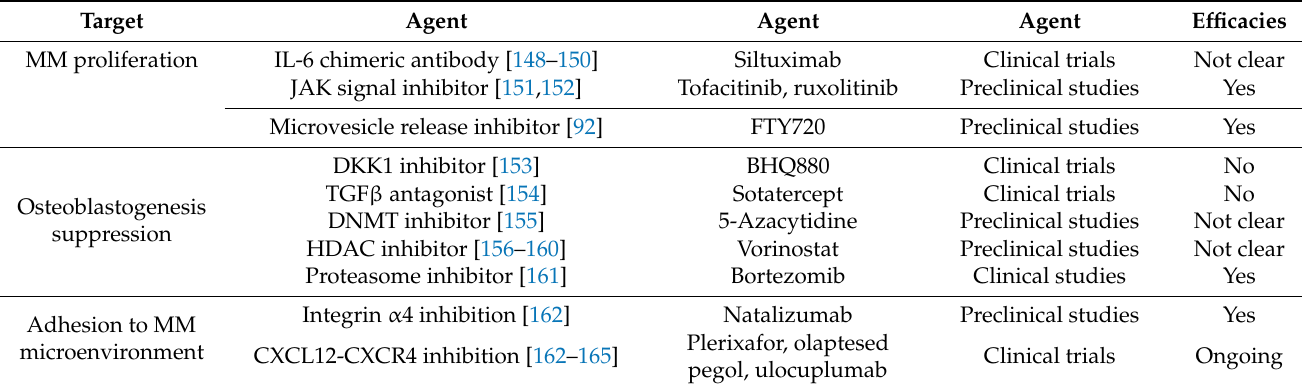
Table 2. Agents for targeting the effects of